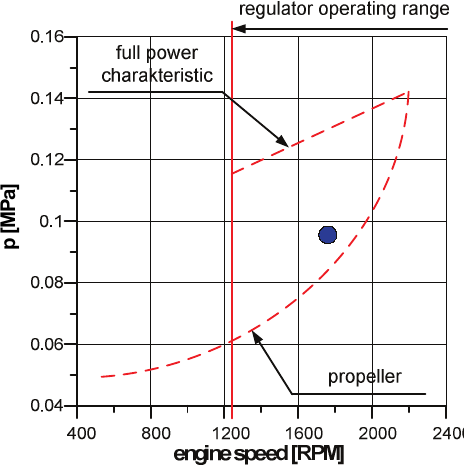
Fig. 3. Operating range and the measuring point [6]